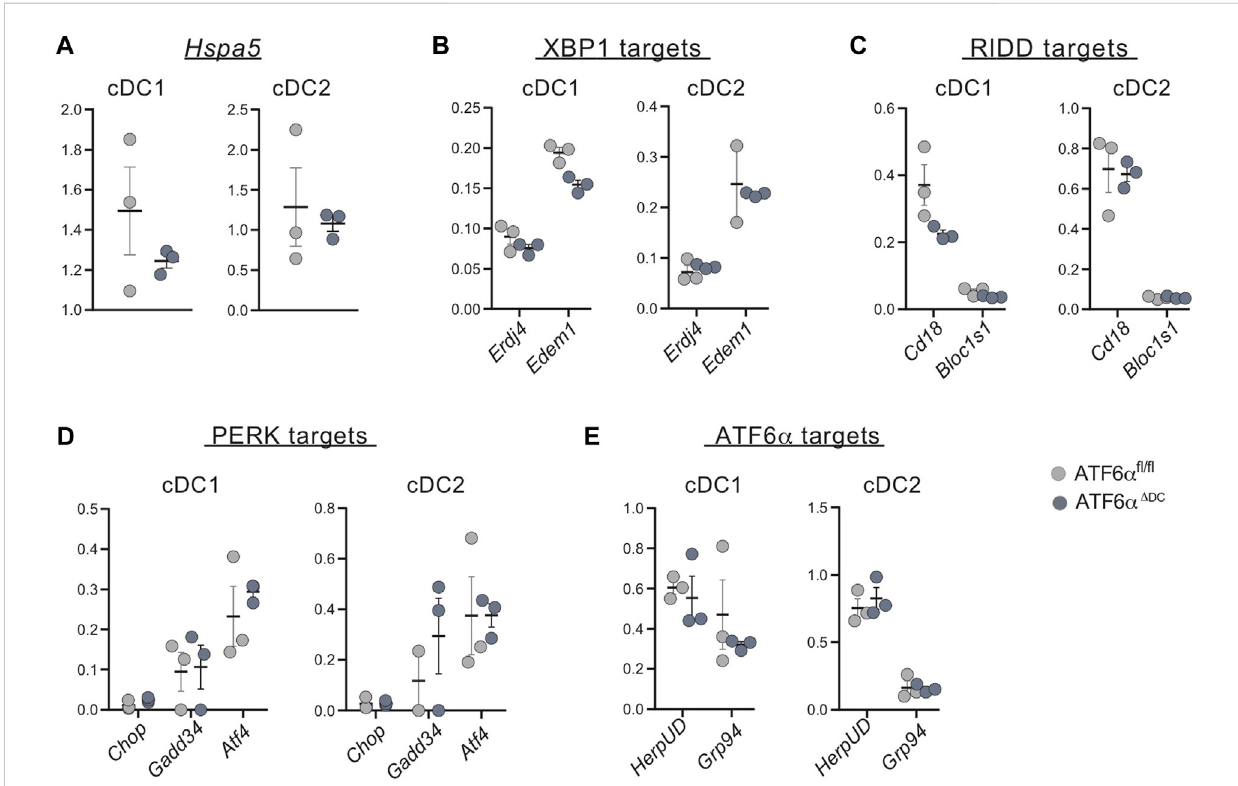
FIGURE 4 ATF6 α de fi cient cDCs express normal level of UPR components. qPCR analysis of basal expression of UPR target genes from sorted spleen cDCs of ATF6 α fl / fl ( n = 3 mice) and ATF6 α Δ DC mice ( n = 3 mice). (A) Expression of Hspa5 (BiP) was used as a readout of ER stress, and speci fi c target genes of (B) IRE1-XBP1axis, (C) RIDDbranch, (D) PERKand (E) ATF6 α pathwayswerequanti fi edbyqPCR.RNAexpressionwasnormalizedtohousekeepinggenesL27. Each symbol represents the sample obtained from one mouse in two independent experiments. For statistical analyses, the non-parametric Mann- Whitney test was